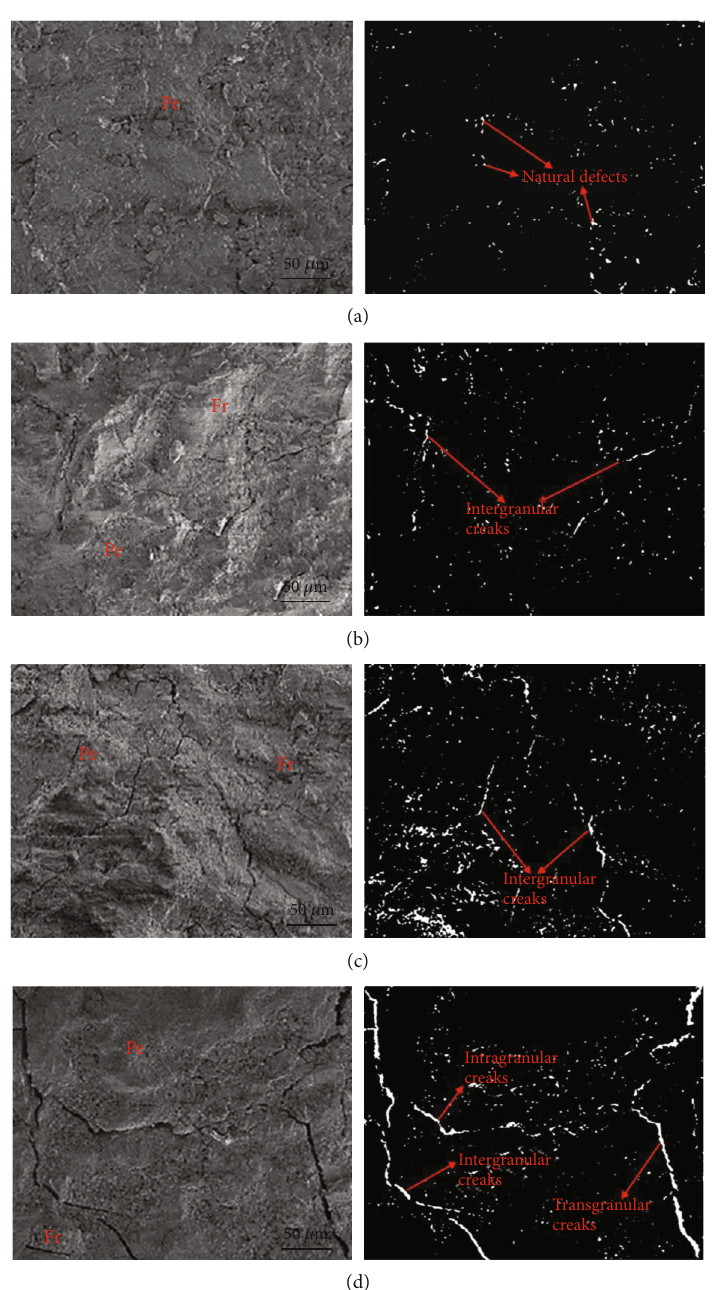
Figure 10: SEM images of basalts: (a) nontreated, (b) exposed at 5 kW for 10 s, (c) exposed at 3 kW for 90 s, and (d) exposed at 1 kW for